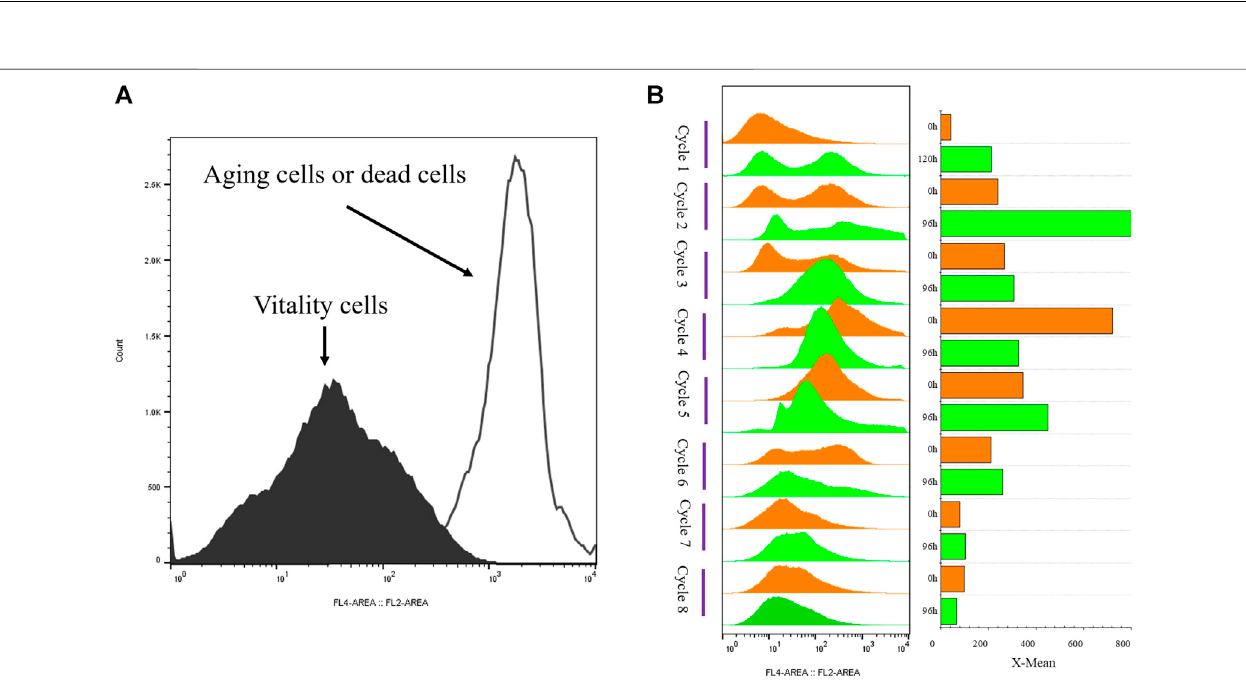
FIGURE3| Histogramof fl owcytometry andcell vitality ofG/Pel. (A) Negativeand positivehistogram of fl owcytometry. (B) G/Pelcell vitality after semi-continuous cultivation. The left side shows a histogram of fl ow cytometry, and the histogram migrates to the right, with increased fl uorescence and decreased cell vitality. The right side shows the statistical data of fl uorescence detected by fl ow cytometry at different time points. Y-axis: fermentation cycles; each cycle contains two points. 0 h (orange), the viability of remaining cells; 120 or 96 h (green), the cell viability at the end of the fermentation cycle. X-axis: the cell viability values.